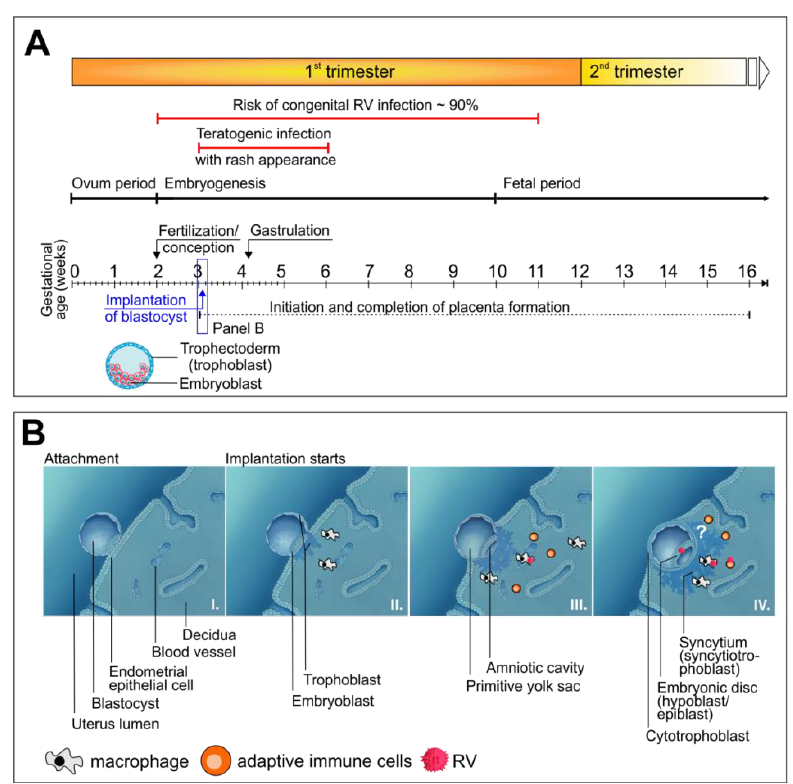
Figure 1. Timeline of congenital defects from maternal rubella virus (RV) infection in relation to embryonal stages. ( A ) The timeline of maternal RV infection with a high rate of congenital defects is given in direct comparison to first trimester embryonal development. The timeline refers to gestational age and starts from the first day of the last menstrual period. Highlighted is the blastocyst, which is composed of the embryoblast as the inner cell mass and the trophectoderm or trophoblast as its outer cell layer. ( B ) The inner cell mass of the blastocyst, the so-called embryoblast, transforms into a double layer, the hypoblast and epiblast. The hypoblast or primitive endoderm develops into the fluid-filled amniotic cavity, which later harbors the embryo. The epiblast gives rise to the embryo, which results in formation of the embryonic disc. The implantation of the blastocyst is followed by infiltration with maternal immune cells, which could potentially provide access of RV to the embryo. The question mark indicates this hypothesized mode of viral transfer. As a reference for ( A ) and ( B ), please refer to the main text, especially for the time line of congenital rubella infection in relation to gestational age to [11,14]. The timeline for teratogenic RV infection in relation to appearance of the rash in the mother is given in [12].